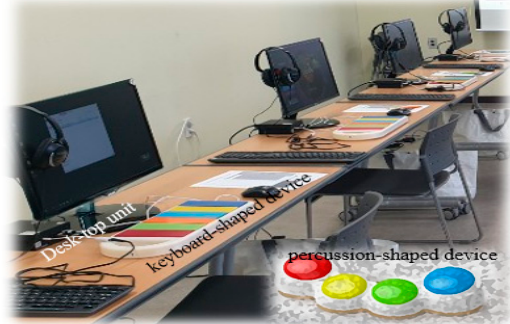
Figure 2. Basic settings of devices. Therapeutic musical devices comprise a desk-top unit, monitor, speaker, headphone, and percussion- and keyboard-shaped electrical devices on the